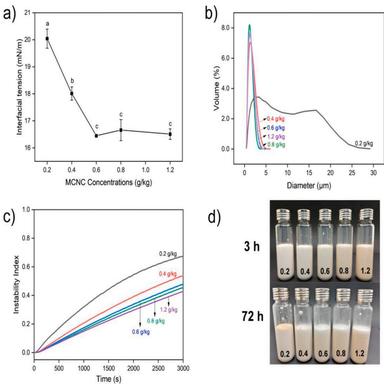
Effect of MCNC concentrations on properties of MCNC-PE. a) Oil-water interfacial tension of MCNC dispersion at different concentration; b) Particle size distribution; c) instability index and d) images of MCNC-PE stabilized by MCNC at different concentrations: 0.2, 0.4, 0.6, 0.8 and 1.2 g/kg. Different letters indicate significant differences (p < 0.05). MCNC, magnetic cellulose nanocrystals; MCNC-PE, magnetic cellulose nanocrystals stabilized Pickering emulsion.